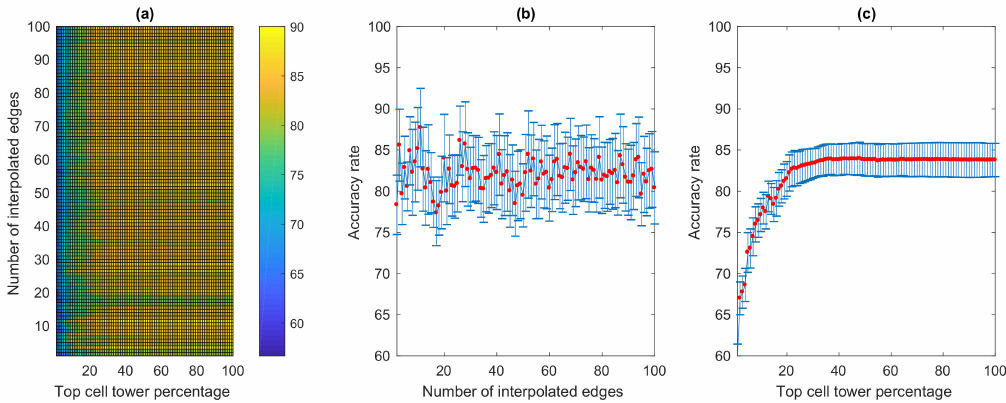
Figure 17. Results based on the interpolation-based method: ( a ) overall accuracy rates; ( b ) average and standard deviation of the accuracy rates of varying numbers of interpolated edges; ( c ) average and standard deviation of the accuracy rates of varying numbers of top cell tower